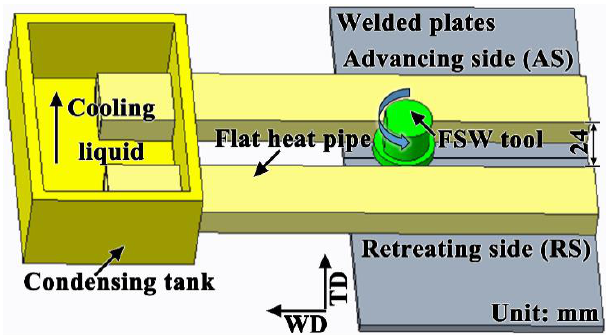
Figure 1. Schematic illustration of the setup of heat pipe-assisted friction stir welding (HFSW). The welding direction is marked as WD and the direction perpendicular to it is marked as TD.